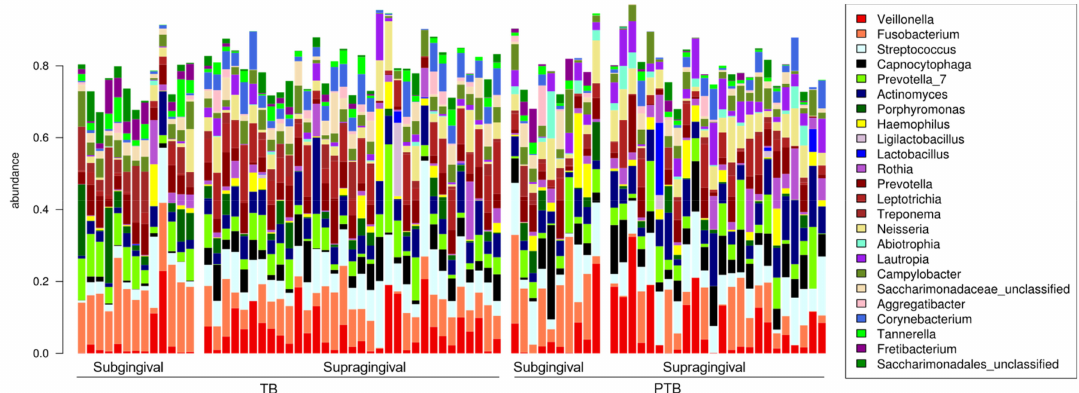
Figure 4. Barplot, abundance of supra- and subgingival samples for the preterm birth group (PTB) and term birth group (TB). Note: TB = Term birth; PTB = Preterm birth.